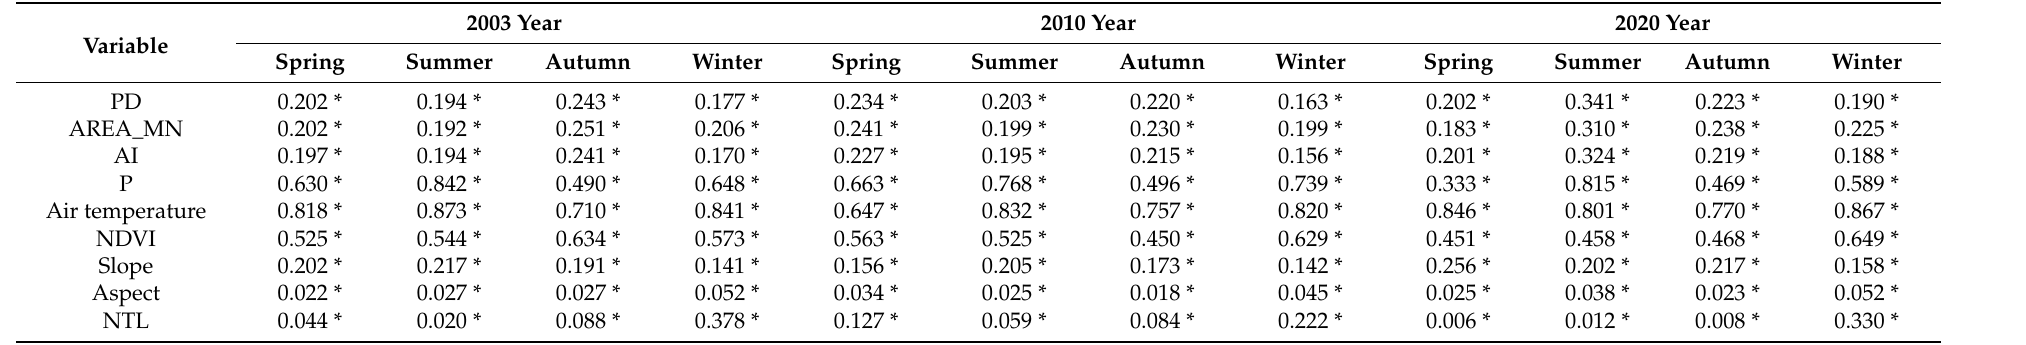
Table 5. Factor detection q-value table from 2003 to